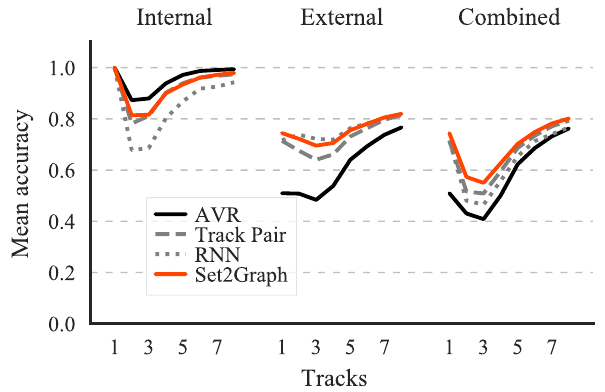
Fig. 10 Vertex performance as a function of the vertex size. Internal, external and combined accuracy are defined in Sect. 4.2 Figure 11 show the performance for vertex pairs, as a function of the distance between the vertices. Again the S2G shows a promising ability to separate vertices even when the distance between them approaches 0. The performance increase of about 10% in combined accuracy comes from the improvement in interpair and external accuracy, i.e., less merging of vertices.